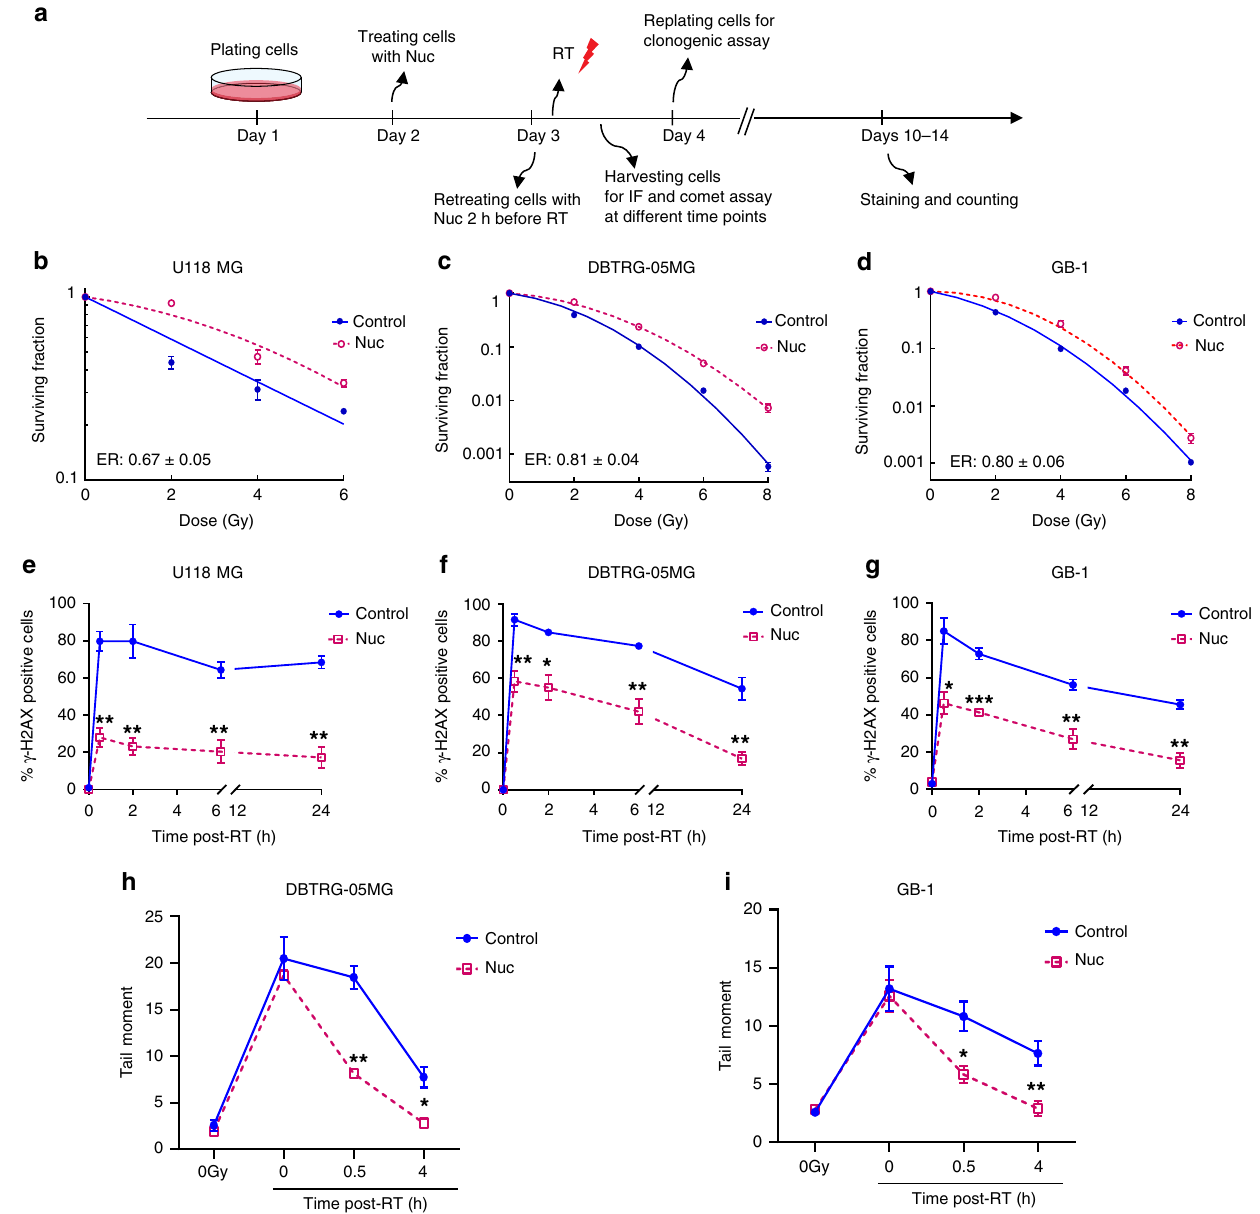
Fig. 2 Supplementing nucleoside pools promotes DNA repair and RT-resistance in GBM. a A schematic timeline of treatment in the RT-sensitive cell lines. U118 MG, DBTRG-05MG, or GB-1 cells were treated with exogenous pooled nucleosides (Nuc; 8×) for 24 h, and retreated with nucleosides 2 h before RT with indicated doses, followed by IF, comet assay, or clonogenic assay. b – d U118 MG, DBTRG-05MG, and GB-1 cells were treated as described in Fig. 2 a , followed by clonogenic assay. ER indicates the Enhancement Ratio, which is the ratio of Dmid control and Dmid treatment. ER > 1 indicates radiosensitization while ER < 1 indicates radioprotection. Fig. b – d show representative fi gures from one of three biologic repeats for each cell line, each performed in technical triplicate. Error bars indicate mean ± SEM from technical triplicates from that single representative experiment. In the lower left of each graph, ER (mean ± SEM) from the three biologic replicates is shown. e – g Cells were treated as above and harvested for γ -H2AX foci IF staining at indicated times post-RT. Data are presented as mean ± SEM from 3 biologically independent experiments. p values of 0.5, 2, 6, and 24 h are 0.0021, 0.0050, 0.0044, and 0.0035 for Fig. e ; 0.0071, 0.0134, 0.0069, and 0.0056 for Fig. f ; 0.0140, 0.0007, 0.0093, and 0.0035 for Fig. g – i . DBTRG-05MG or GB-1 cells were treated as above and harvested at different time points for alkaline comet assay. Cells were irradiated and harvested on ice for the 0 h time point (4 Gy; 0 h). Data are presented as mean ± SEM from 3 ( h ) or 4 ( i ) biologically independent experiments. p values of 0, 0.5 and 4 h are 0.4996, 0.0019, and 0.0145 for Fig. h ; 0.8050, 0.0152, and 0.0080 for Fig. i . Fig. e – i : * p < 0.05 and ** p < 0.01, *** p < 0.001 compared with control. The p values indicated in Fig. e – i were obtained by two-tailed unpaired student's t test. Source data are provided as a Source Data fi